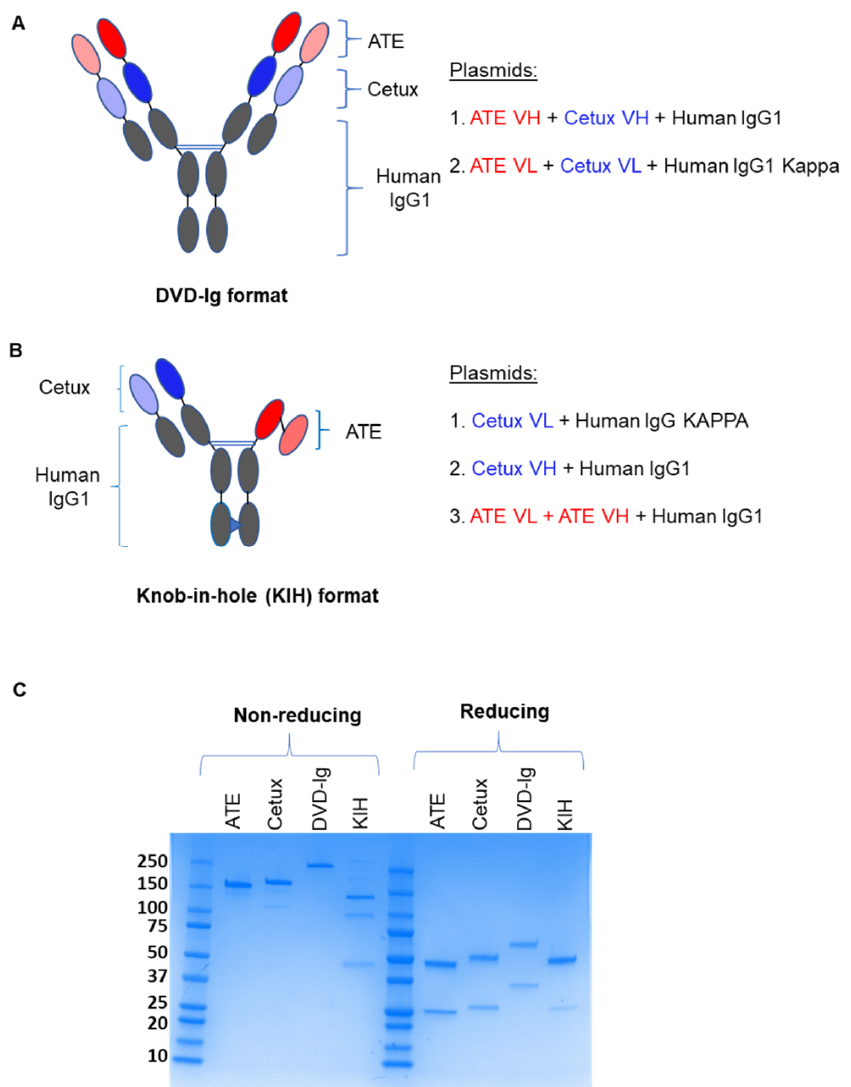
Figure 1. Construction and schematic representation of anti-EGFR/PD-L1 BsAbs: ( A ) Dual variable domain immunoglobulin (DVD-Ig) symmetric tetravalent format of anti-EGFR/PD-L1 BsAb in which single-chain variable fragments of ATE and Cetux are connected to the human IgG Fc portion. ( B ) Knob-in-hole (KIH) asymmetric bivalent format of anti-EGFR/PD-L1 BsAb in which two half- heavy chains containing “knob” mutations (T350V_L351Y_F405A_Y407V) and “hole” mutations (T366L_K392l_T394W) were generated. scFv ATE (light and dark red); scFv Cetux (light and dark blue); human Fc-IgG1 (grey). ( C ) SDS-PAGE analysis showing the heavy and light chains of DVD-Ig and KIH formats of purified anti-EGFR/PD-L1 BsAbs, ATE and Cetux under non-reducing and reducing